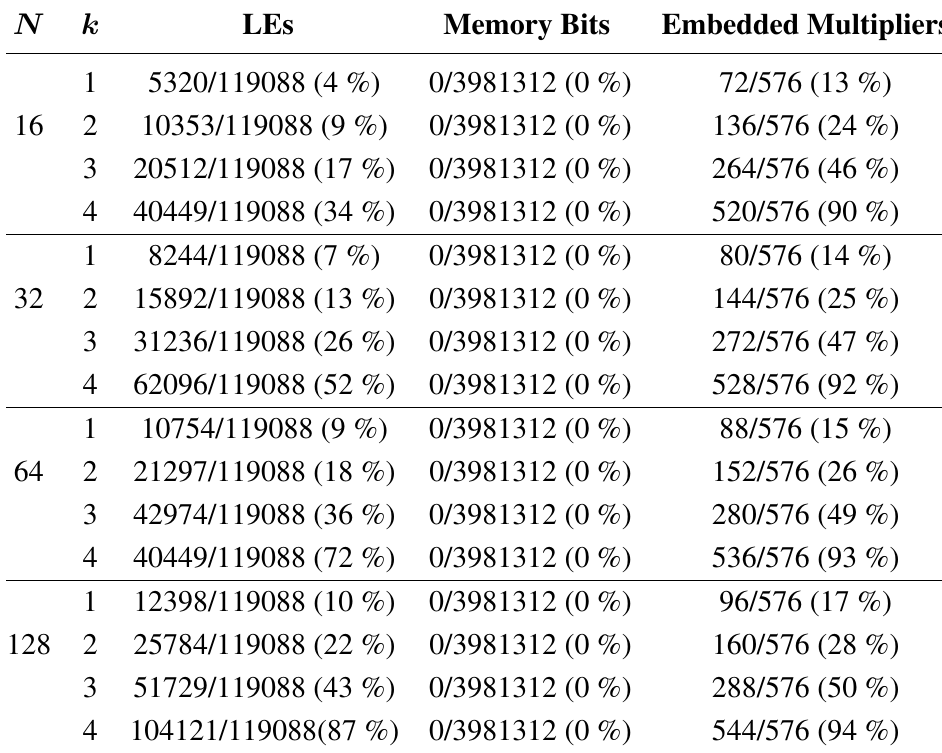
Table 3. The area costs of the proposed architecture for different number of stages N with various k .